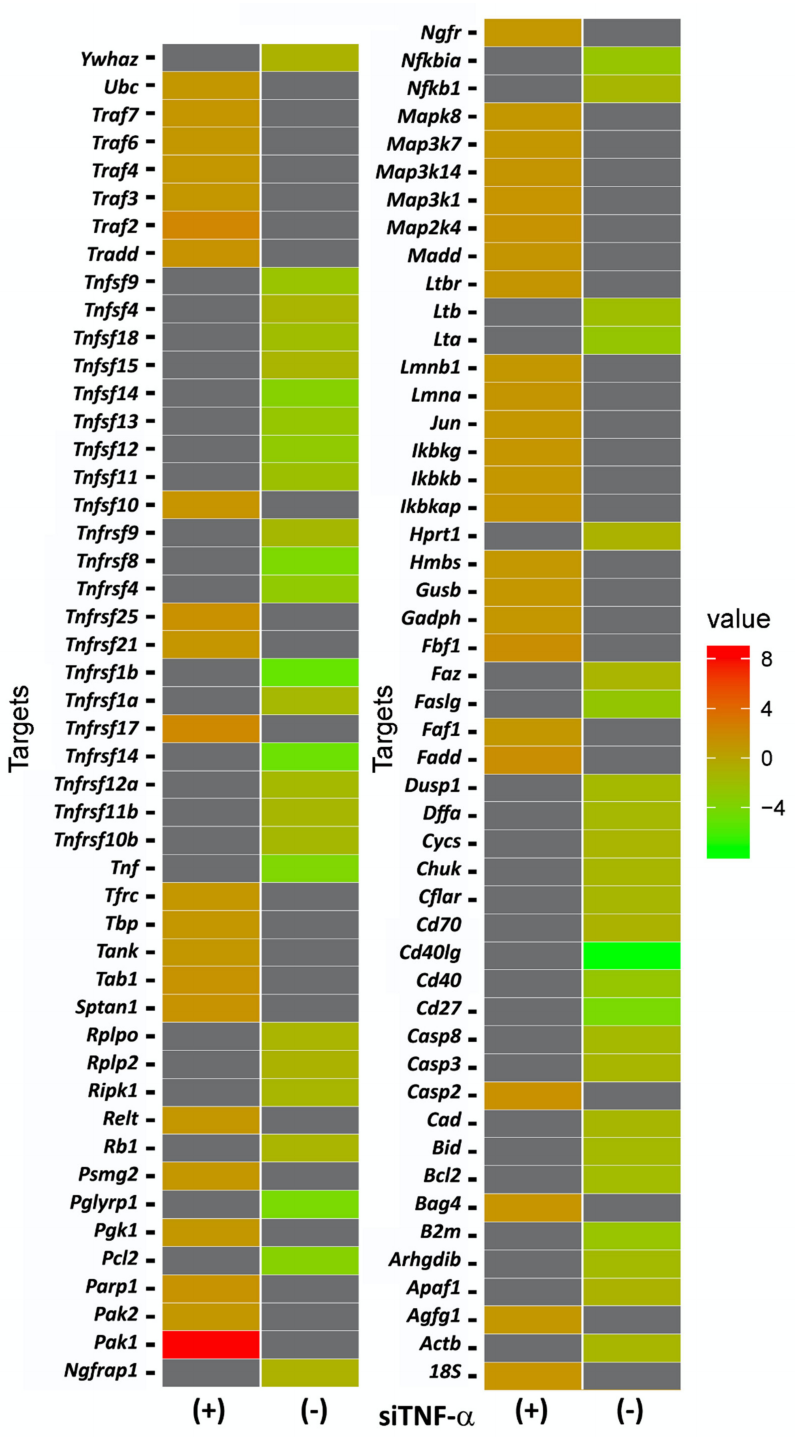
Figure 2. A heat map showing the comparisons of di ff erential gene expression of the TNF α metabolic pathway in the cochleae of rats previously submitted ( n = 20) or not submitted ( n = 20) to Tnf α siRNA administration and after noise exposure. According to the fold-change found by the qRT-PCR analysis, the “red” color is used to indicate the highest gene expression (up-regulated genes), whereas the “green” color is used to indicate the lowest gene expression (down-regulated genes). In the “gray” color are presented the gene expression values (or transcript values) that were poorly evaluated due to insu ffi cient resolution or image noise, which, in a general way, are named as “missing